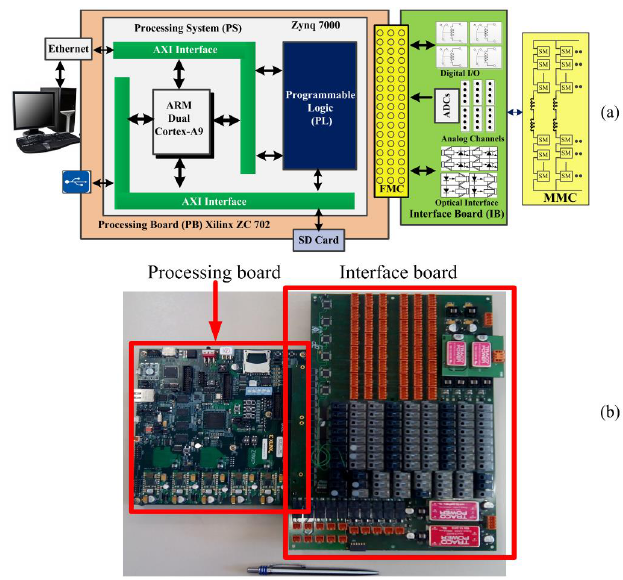
Figure 15. ( a ) Block diagram; ( b ) picture of the control platform.